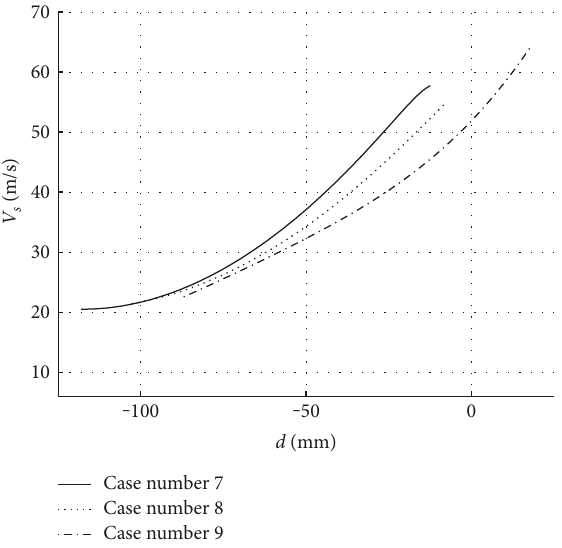
Figure 10: Slip velocity pro fi les for cases #7, #8, and #9 as a function of the droplet horizontal distance to the airfoil leading edge.